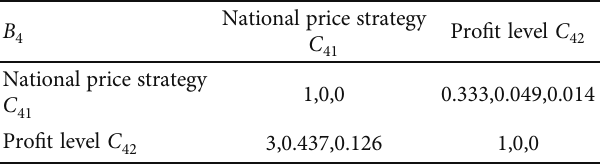
Table 8: The judgment matrix of B